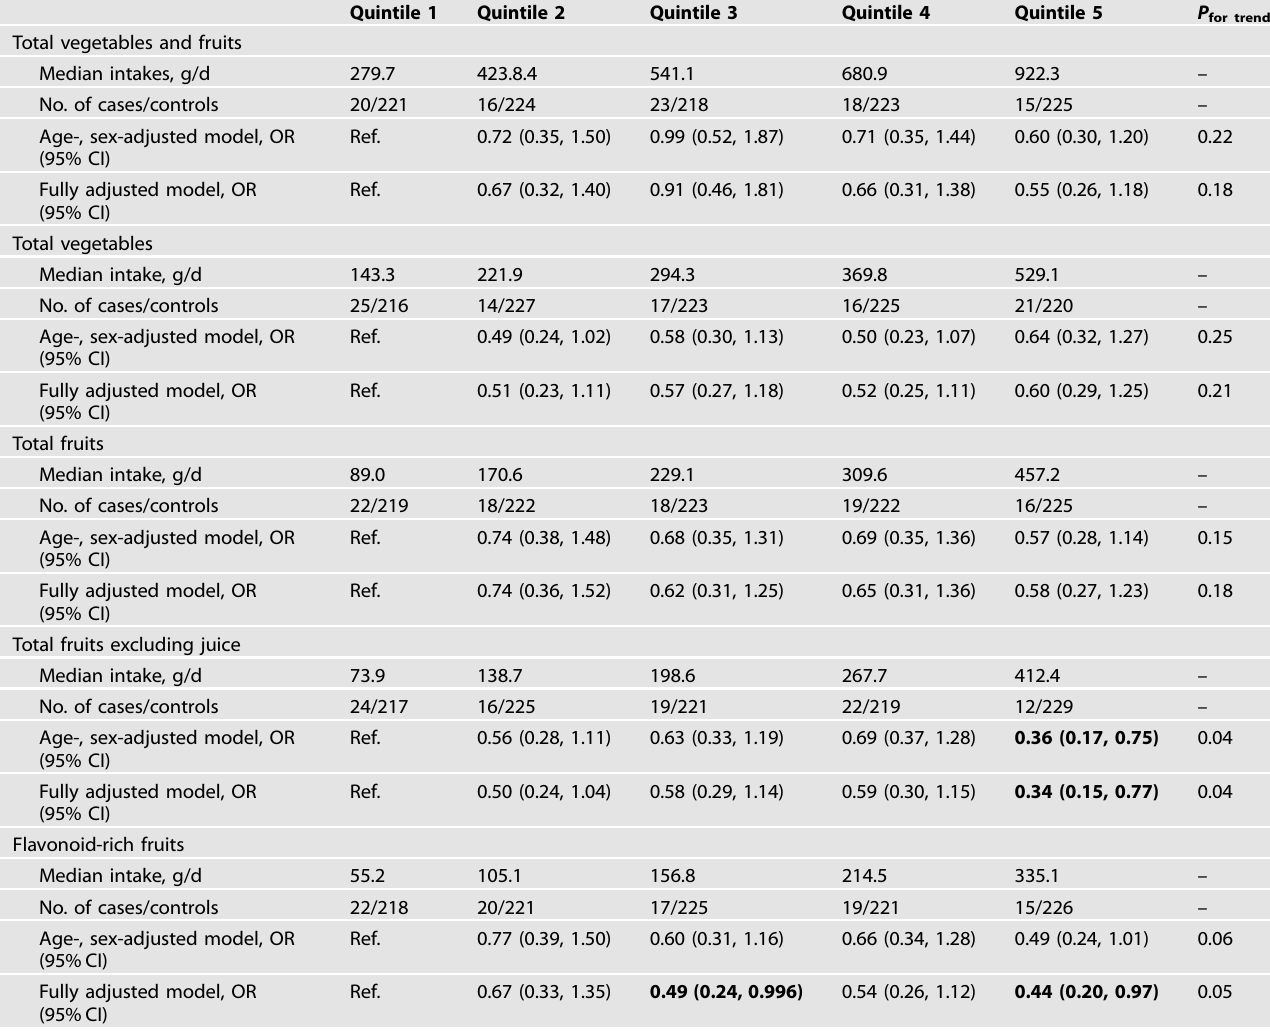
Table 2. Odds of major depressive disorder according to quintiles of vegetable and fruit